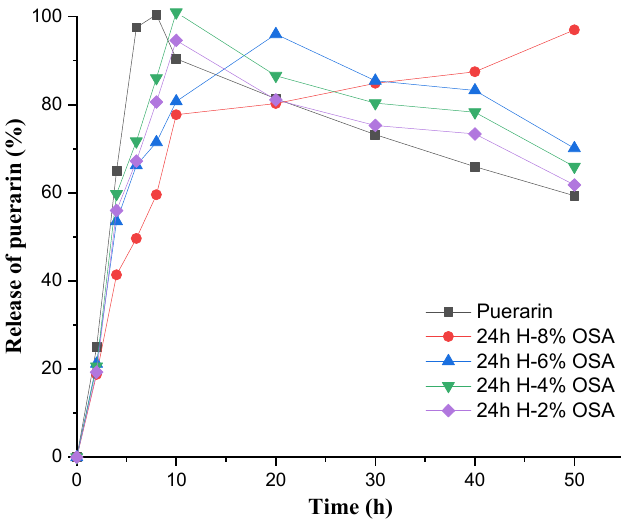
Figure 10. Profiles of in vitro release of Pue from different Pickering emulsions.